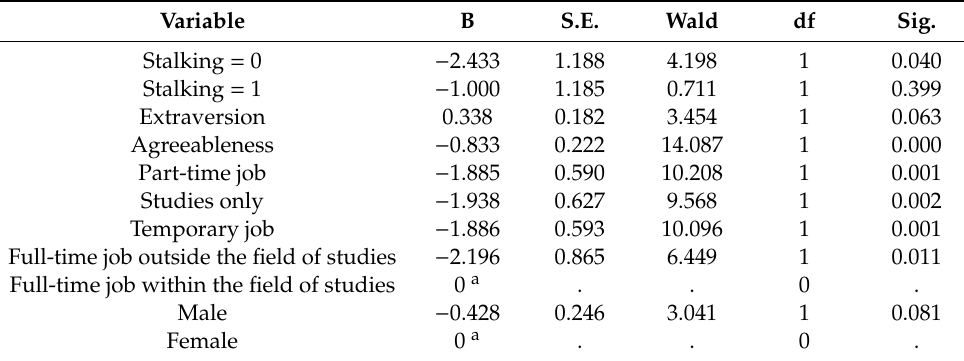
Table 4. Streamlined Model 2—Stalking: ordinal logistic